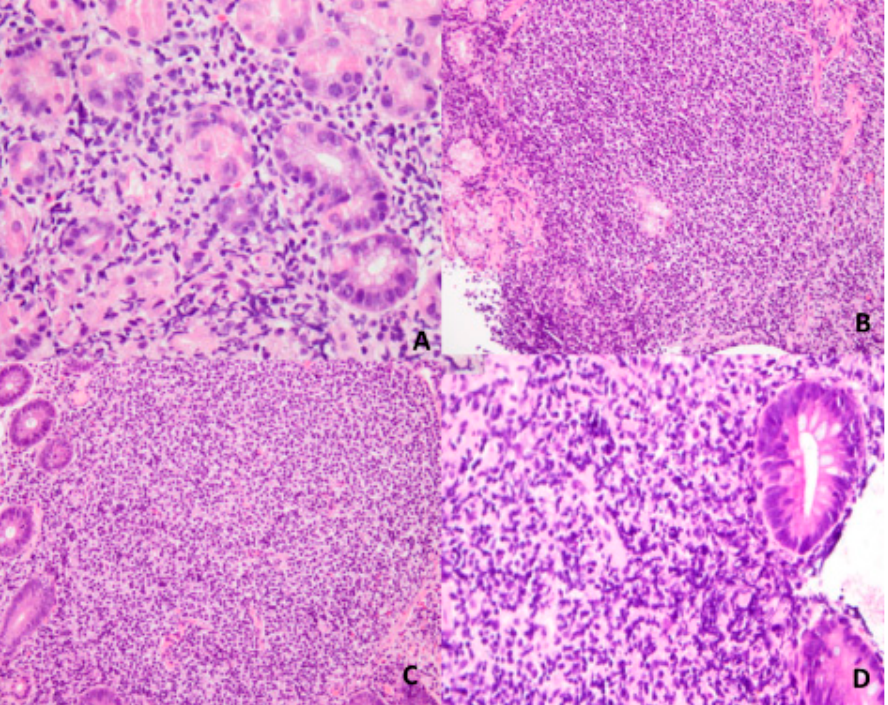
Figure 3. The pathology revealed MALToma in the stomach ( A ), duodenum ( B ), terminal ileum ( C ), and sigmoid ( D ). and sigmoid ( D